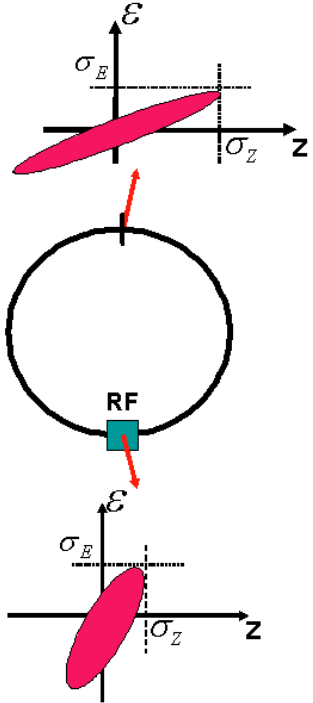
FIG. 1. (Color) Longitudinal phase space in different points of the